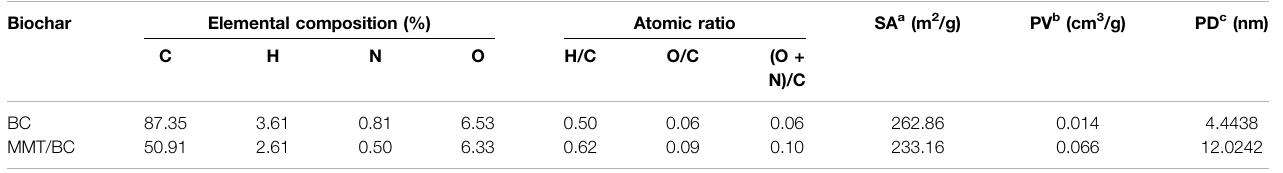
TABLE 1 | Physical and chemical characteristics of BC and MMT/BC.